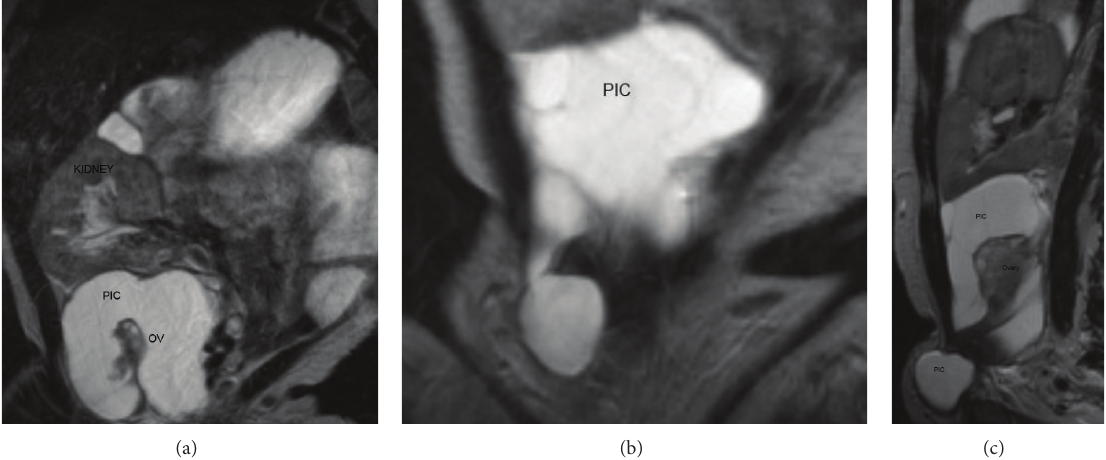
Figure 2: (a) Coronal T2 MR image demonstrating a cystic mass (PIC) containing ovarian tissue (OV) in the right adnexal region, extending into the inguinal canal. A transplanted right pelvic kidney is noted. (b) Coronal T2 MR image of peritoneal inclusion cyst (PIC) with extension to the right inguinal canal. Note “spider web” septations. (c) Sagittal T2 MR image of peritoneal inclusion cyst (PIC) with “spider web septations” containing ovarian tissue, with extension to the right inguinal